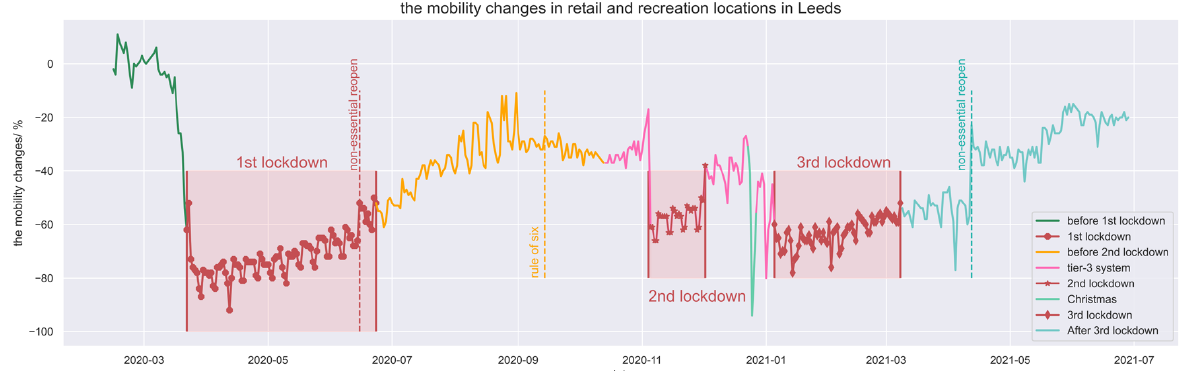
Figure 6. The mobility changes of retail and recreation locations in Leeds. The first lockdown